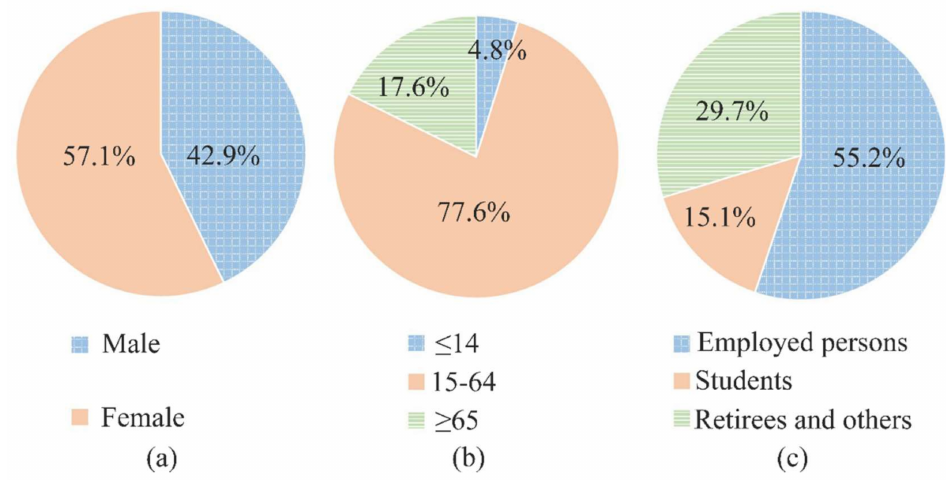
Figure 4. Distribution of respondents’ ( a ) gender, ( b ) age, and ( c ) employment.